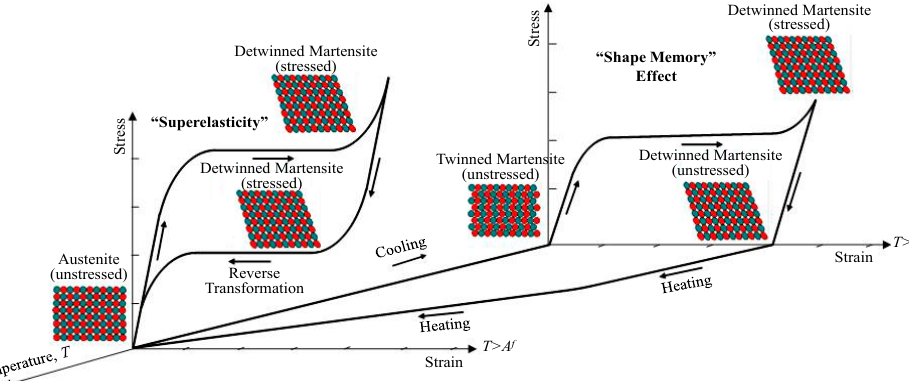
Figure 1. Behavior of superelastic shape memory alloy (SMA) materials according to phase